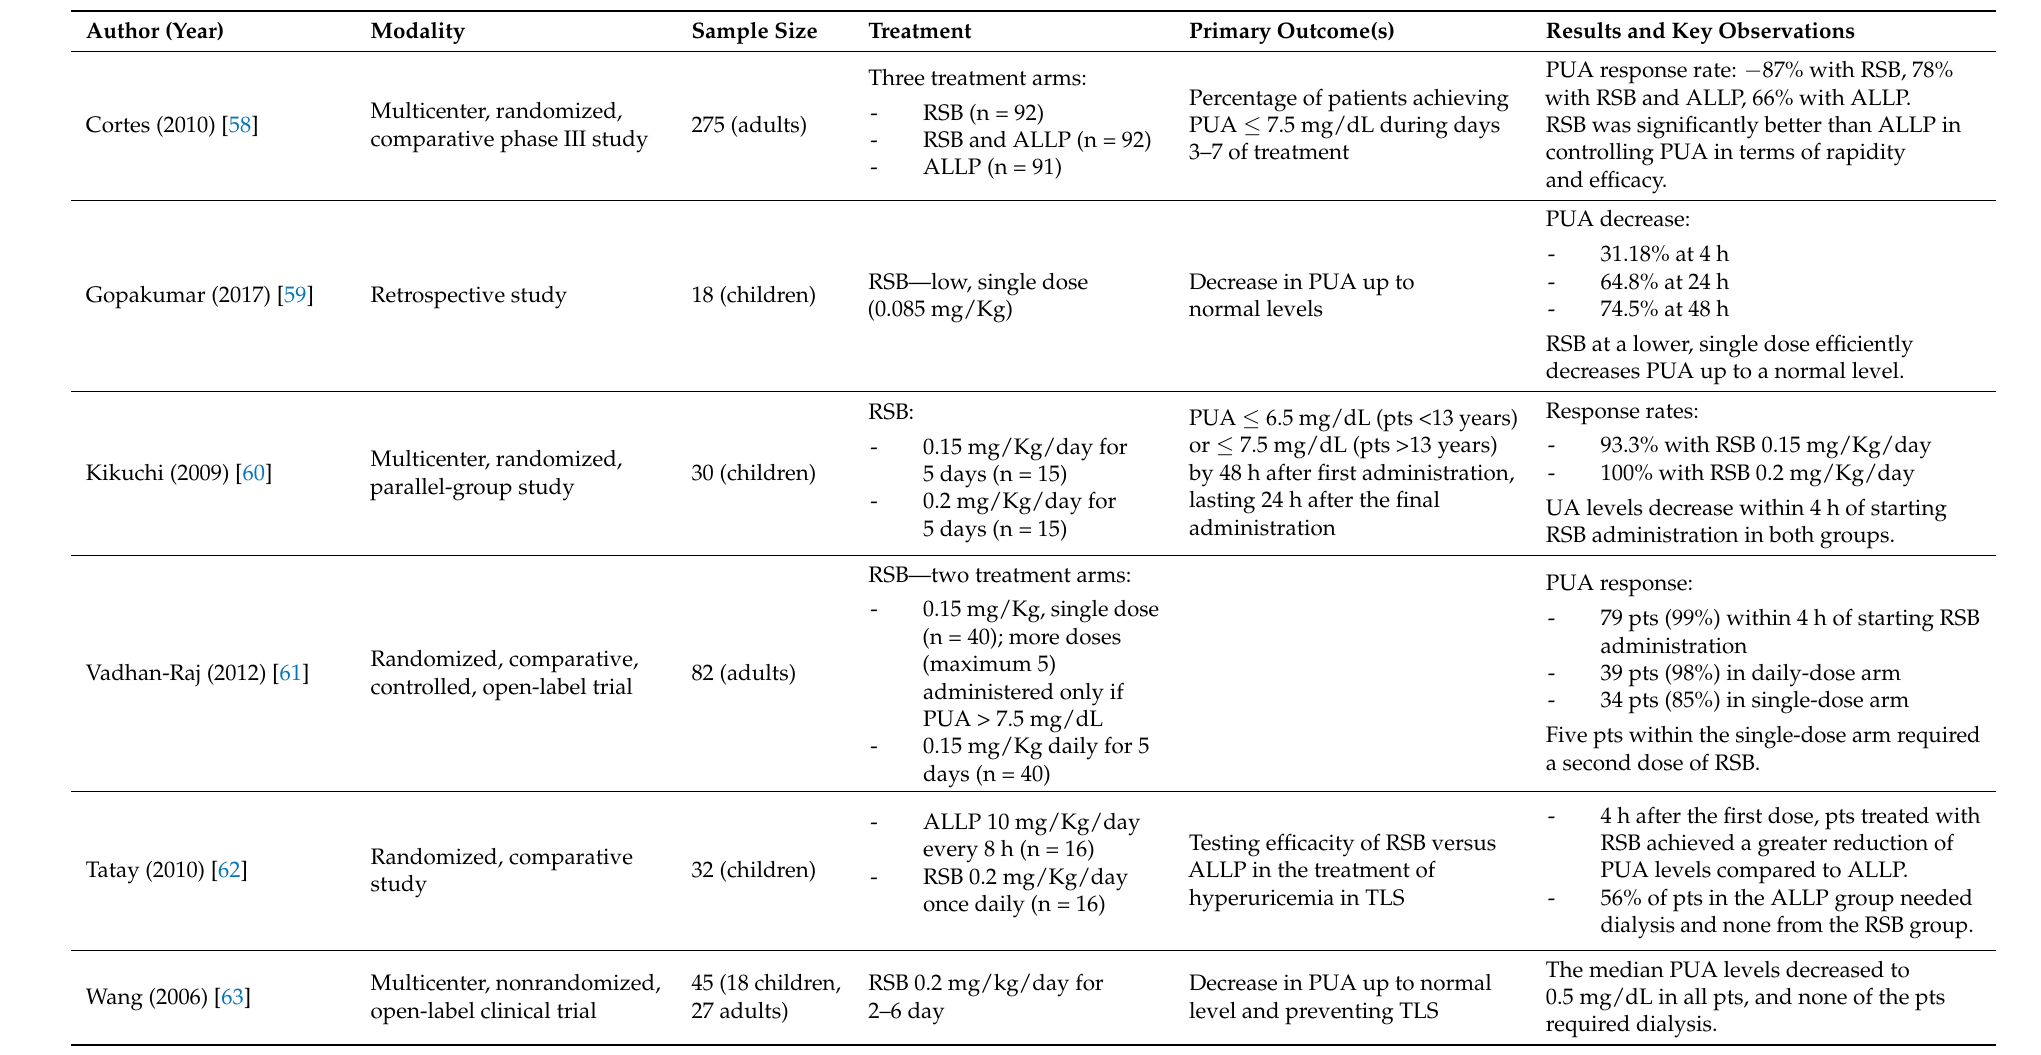
Table 5. Studies evaluating the efficacy of rasburicase in the prevention/treatment of tumor lysis